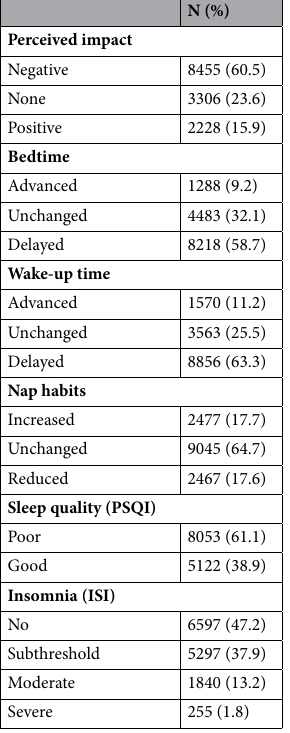
Table 1. Prevalence of lockdown-related consequences and sleep disturbance prevalence within the total